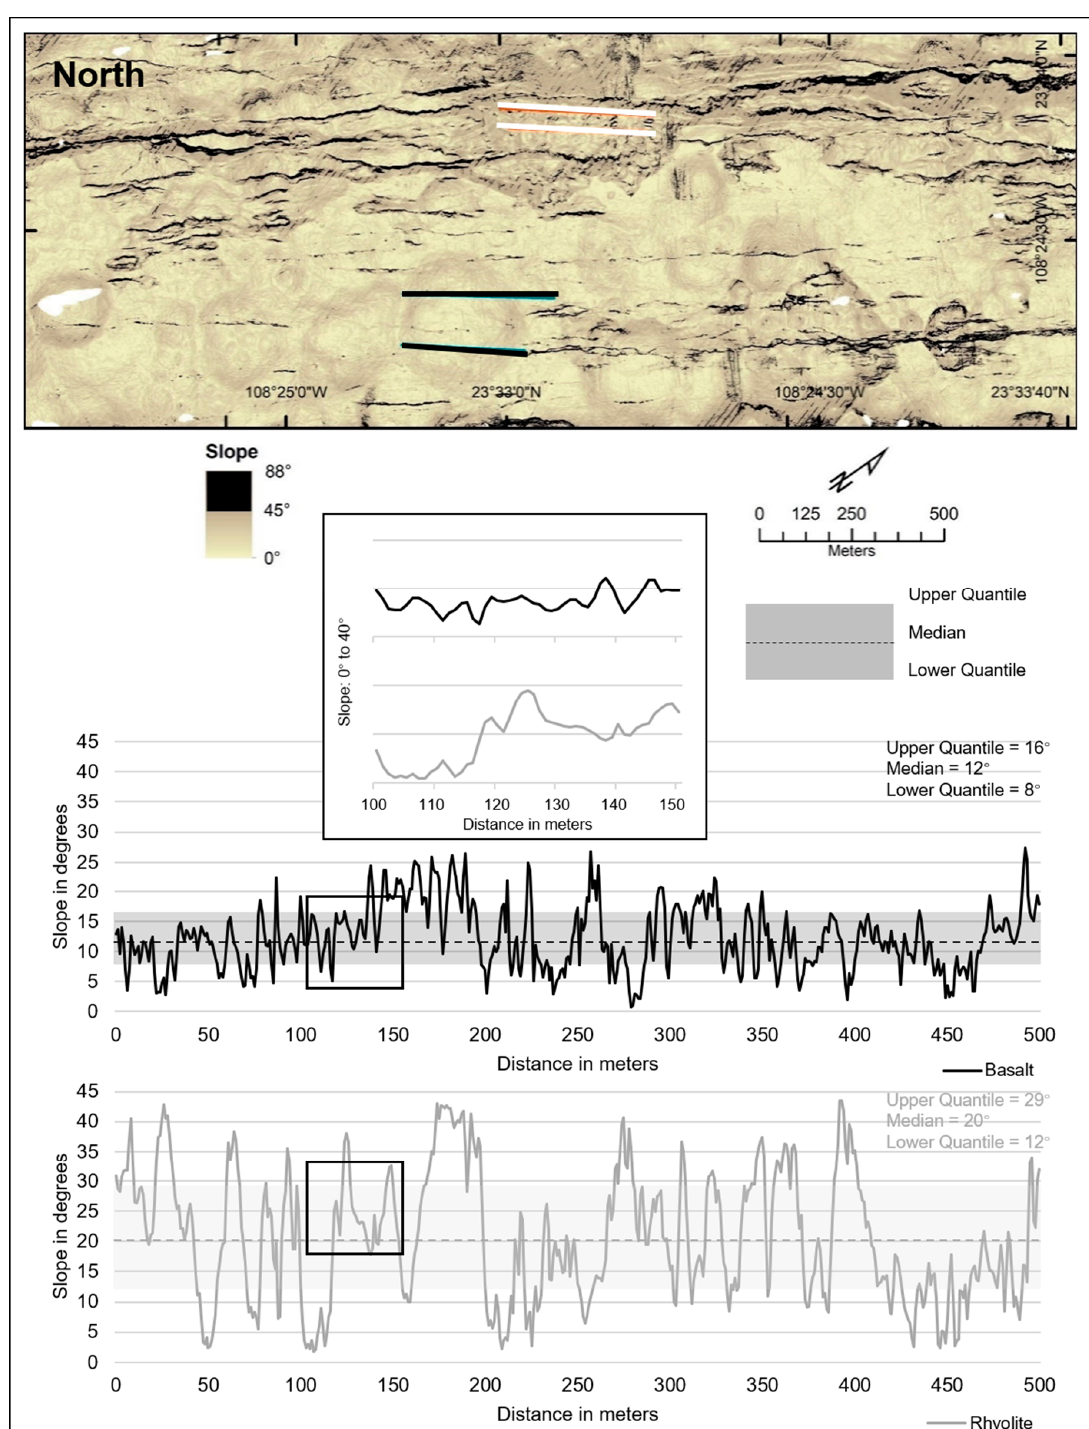
Figure 8. The top panel shows the locations of the slope profiles at the rhyolite dome (white lines) and on a basalt mound (black lines) shown in the lower two panels. The slope profiles were taken parallel to the axis to diminish any residual effects of faulting. Slope values for rhyolitic lava flows are consistently higher than those of basalt pillow mounds. Slope ranges of rhyolite flows are also greater than those of basaltic flows.